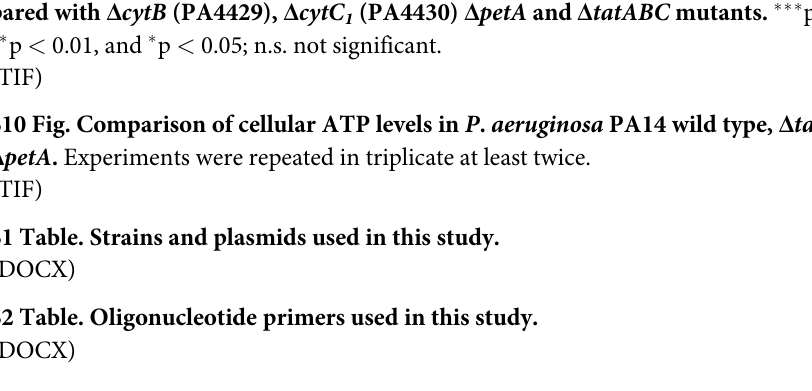
in the P . aeruginosa wild type compared with the Δ tatABC mutant Data are presented as maxi- mal light output as a function of growth (RLU/OD ). Experiments were repeated in triplicate 600 at least twice. S4 Fig. HHQ and PQS do not accumulate intracellularly in a tatA Δ pqsA double mutant harboring the plasmid-borne pqsABCD genes in the absence of autoinduction. Semi-quan- titative analysis by LC-MS/MS of PQS ( A ) and HHQ ( B ) extracted with methanol from whole cell cultures of P . aeruginosa wild type and the tatA Δ pqsA mutant without (control) or with (+ pqsABCD ) the pqsABCD biosynthetic genes provided via pBBR1MCS-5:: pqsABCD and har- vested at 8 h and 16 h respectively. Experiments were repeated in triplicate. S5 Fig. Exogenous rhamnolipids do not enhance PQS-dependent expression of pqsA in a tatA Δ pqsA mutant. PQS (40 μ M) was added with or without purified rhamnolipids (50 μ g/ml) to a pqsA mutant (grey bars) or a tatA Δ pqsA mutant (pink bars) carrying chro- mosomal pqsA’-lux fusions. Maximal light output as a function of growth (RLU/OD ) is 600 presented. Experiments were repeated in triplicate at least twice. S6 Fig. Rhamnolipid biosynthesis gene rhlA shows altered expression profiles in P . aerugi- nosa PA14 Δ tatABC and Δ petA mutants compared with wild type and fail to respond to exogenous PQS. Bioluminescence from a chromosomal rhlA’-lux fusion as a function of growth (RLU/OD) over time when introduced into ( A ) the PA14 wild type, ( B ) Δ tatABC and ( C ) Δ petA mutants in the absence or presence of exogenous PQS (20 μ M). S7 Fig. Deletion of petA in P . aeruginosa PA14 results in a reduction in the eDNA content of biofilms. Biofilms of wild type PA14, the Δ tatABC and Δ petA mutants and the genetically complemented PA14 mutant ( Δ petA ::(CTX:: petA )) were grown cultured statically and stained for eDNA with YOYO-1. ( A ) confocal fluorescence microscopy images and ( B ) eDNA quanti- fication. Experiments were repeated in triplicate at least twice. ��� p < 0.001, �� p < 0.01. S8 Fig. Comparison of pqsA expression in P . aeruginosa PAO1 wild type, Δ tatABC and Δ petA mutants. Experiments were repeated in triplicate at least twice. ��� p < 0.001, �� p < 0.01, and � p < 0.05; n.s. not significant. S9 Fig. Growth, pqsA expression and AQ production in wild type P . aeruginosa PA14 com- pared with Δ cytB (PA4429), Δ cytC (PA4430) Δ petA and Δ tatABC mutants. ��� p < 0.001, 1 �� p < 0.01, and � p < 0.05; n.s. not significant. S10 Fig. Comparison of cellular ATP levels in P . aeruginosa PA14 wild type, Δ tatABC and Δ petA . Experiments were repeated in triplicate at least twice. S1 Table. Strains and plasmids used in this study. (DOCX) S2 Table. Oligonucleotide primers used in this